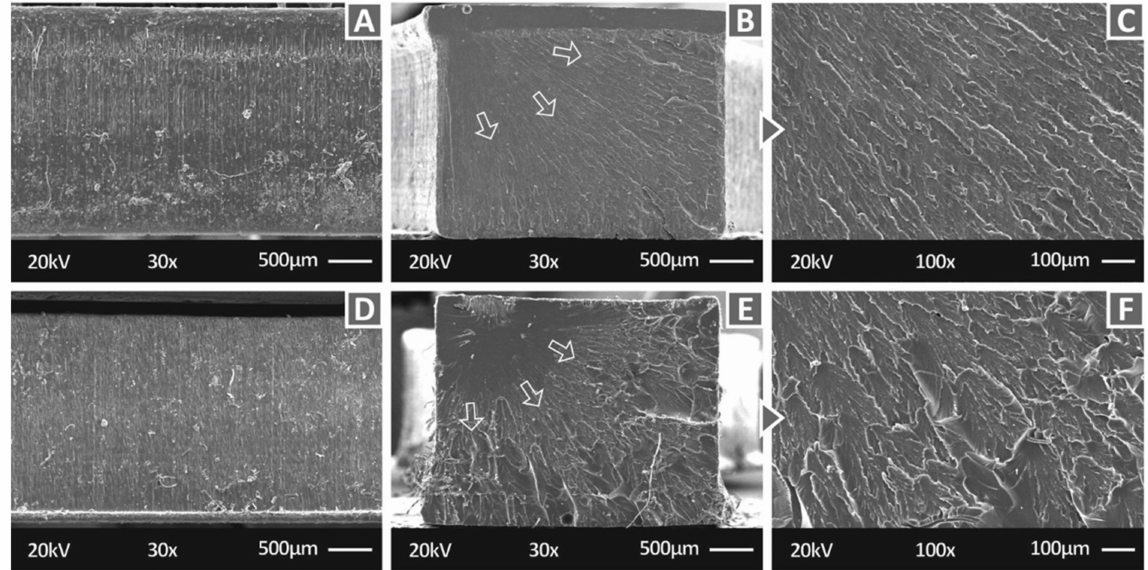
Figure 5. SEM images: ( A ) Pure Biomed Clear 30 × magnification of the side surface, ( B ) Pure Biomed Clear 30 × magnification of the fracture surface, ( C ) Pure Biomed Clear 100 × magnification of the fracture surface, ( D ) Biomed Clear with 1 wt.% CNF 30 × magnification of the side surface, ( E ) Biomed Clear with 1 wt.% CNF 30 × magnification of the fracture surface, and ( F ) Biomed Clear with 1 wt.% CNF 100 × magnification of the fracture surface. Arrows indicate the crack propagation on the fracture area for the two